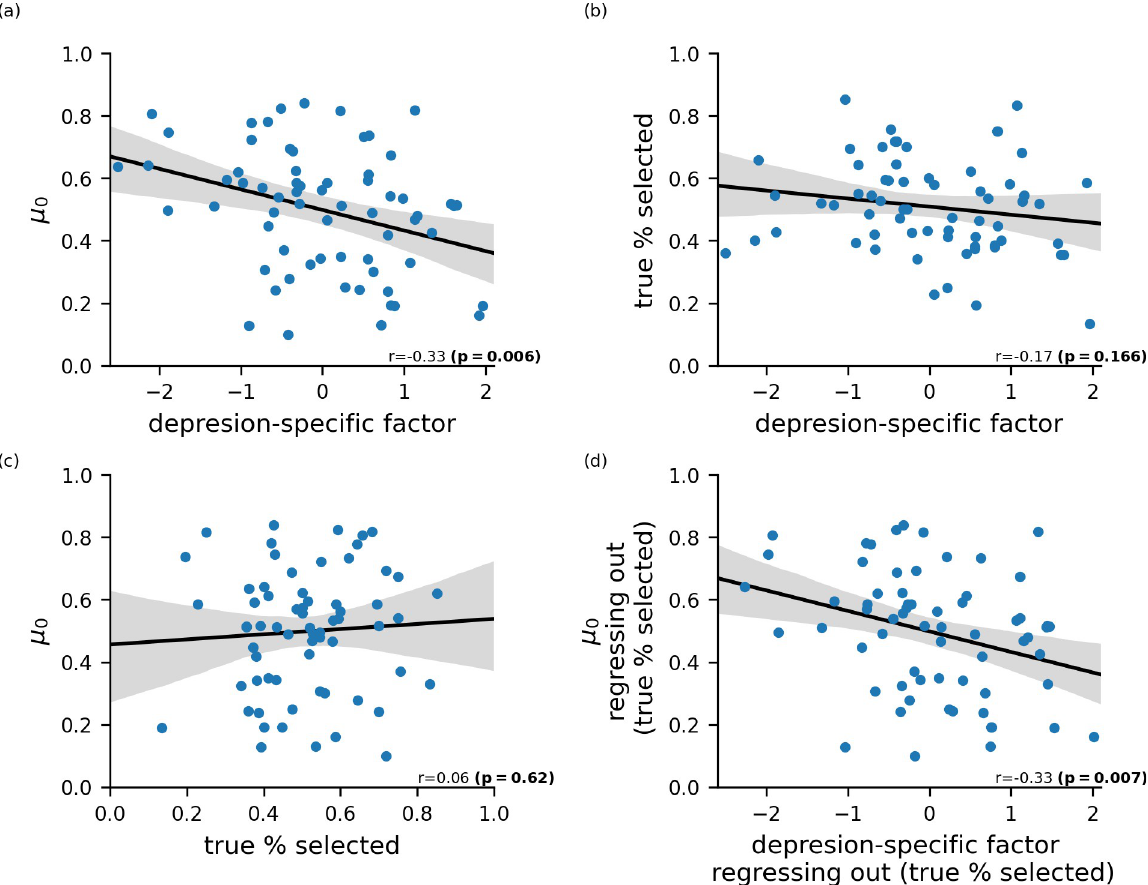
Fig 4. Testing for Depressive Realism. We used the percentage of times that a participant was actually chosen as a potential partner in session 2 (‘true % selected’) to investigate if depression-related differences in starting beliefs ( μ 0 ) might actually reflect accurate perceptions of genuine differences in ‘profile popularity’, i.e., popularity as a potential internship partner. (a) Scores on the depression-specific latent factor were significantly negatively correlated with starting beliefs, r(64) = -0.33, p = 0.006. (b) Scores on the depression-specific factor showed a non- significant negative association with profile popularity (as indexed by true % selected, y-axis), r(64) = -0.17, p = 0.17. (c) Participants had poor insight into their profile popularity; correlation between true % selected and starting belief: r(64) = 0.06, p = 0.62. (d) Partialing out profile popularity (i.e., the true % selected for each participant) had little impact on the significant relationship between depression-specific factor scores and starting beliefs (partial r = -0.33, p = 0.007). A causal mediation analysis [32] confirmed that the relationship between scores on the depression-specific factor and negative starting beliefs was not mediated by profile popularity; Average Causal Mediation Effect (ACME) = 0.0002, p =